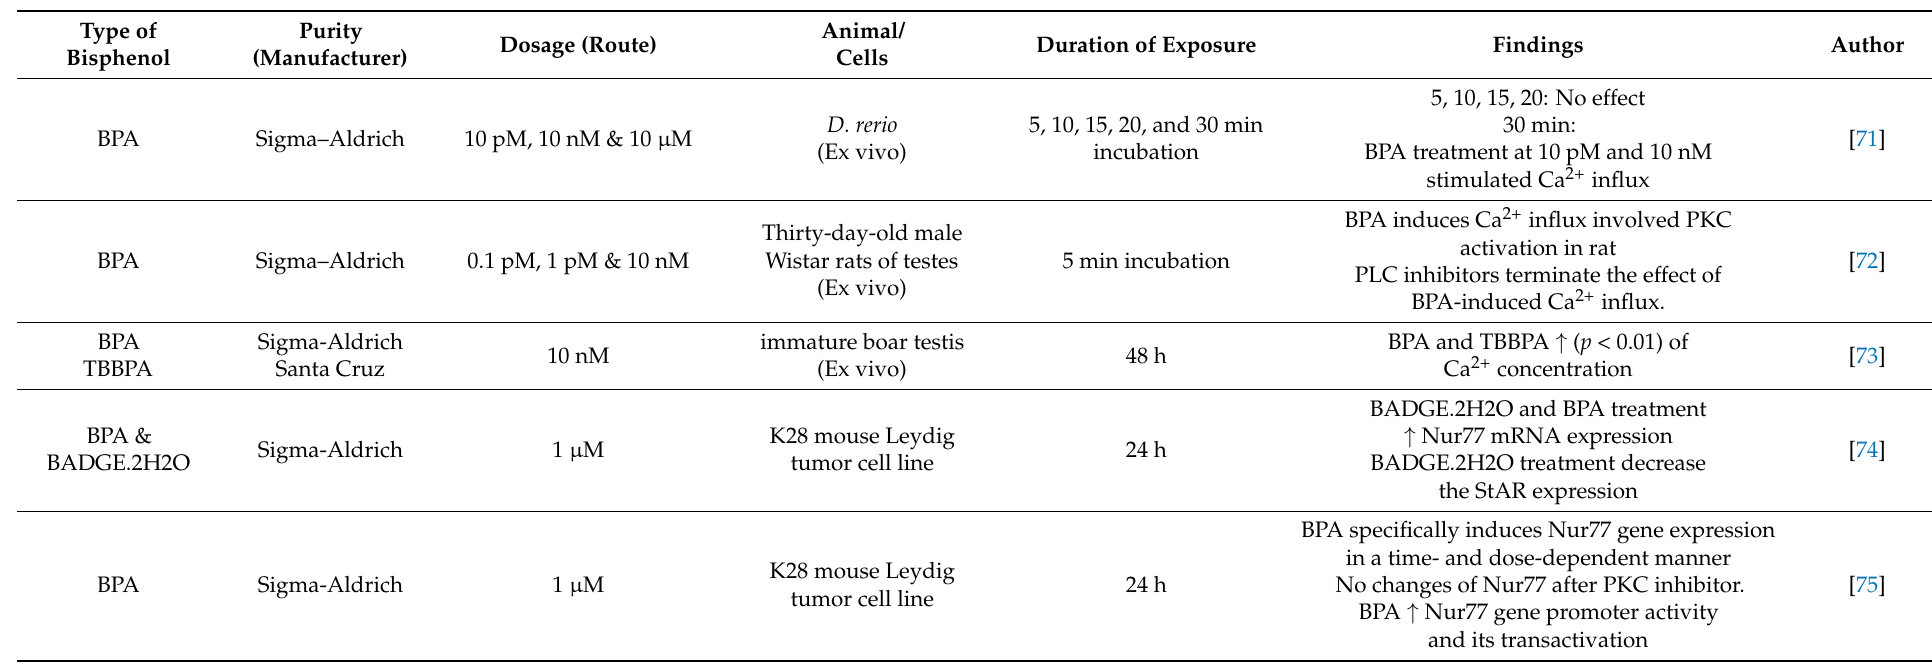
Table 4. The effects of BPA and its analogues on Ca 2+ influx and Nur77 transcription factor in the male reproductive system. Abbreviations: ↑ Increase; ↓